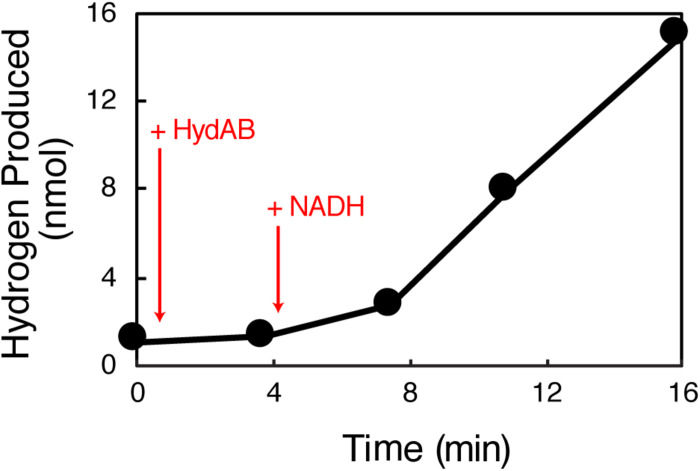
Production of hydrogen from NADH by HydAB independent of reduced ferredoxin. The enzyme assay was performed with 50.7 μg HydAB (+HydAB). NADH was added to a final concentration of 1 mM (+NADH). The maximal rate of hydrogen production in the enzyme assay was 30.1 nanomoles ⋅ min–1 ⋅ mg–1.